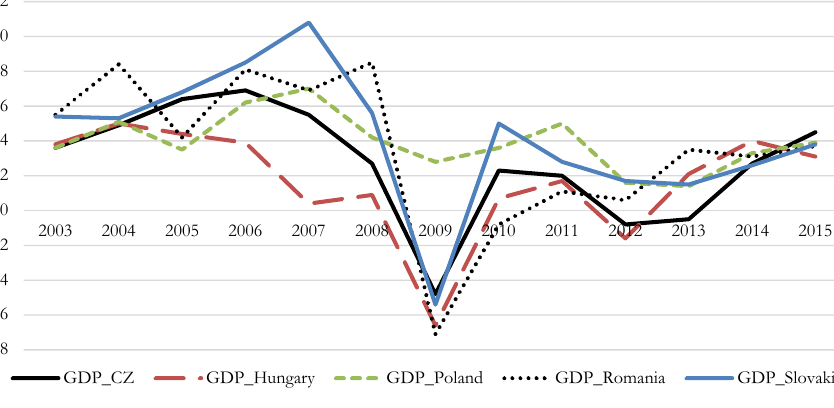
Fig. 1- The evolution of real GDP growth rate in 2003-2015 in V4 countries and Romania.Source: